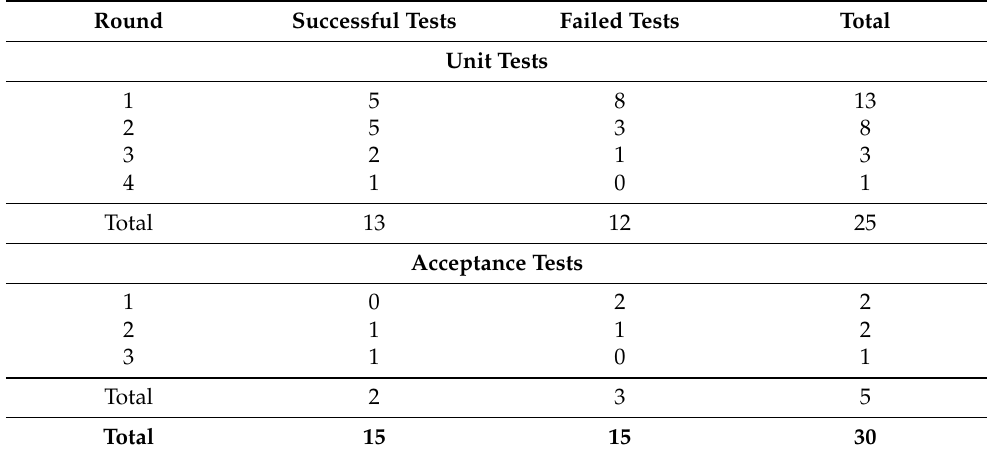
Table 4. Table of tests performed during the first iteration.